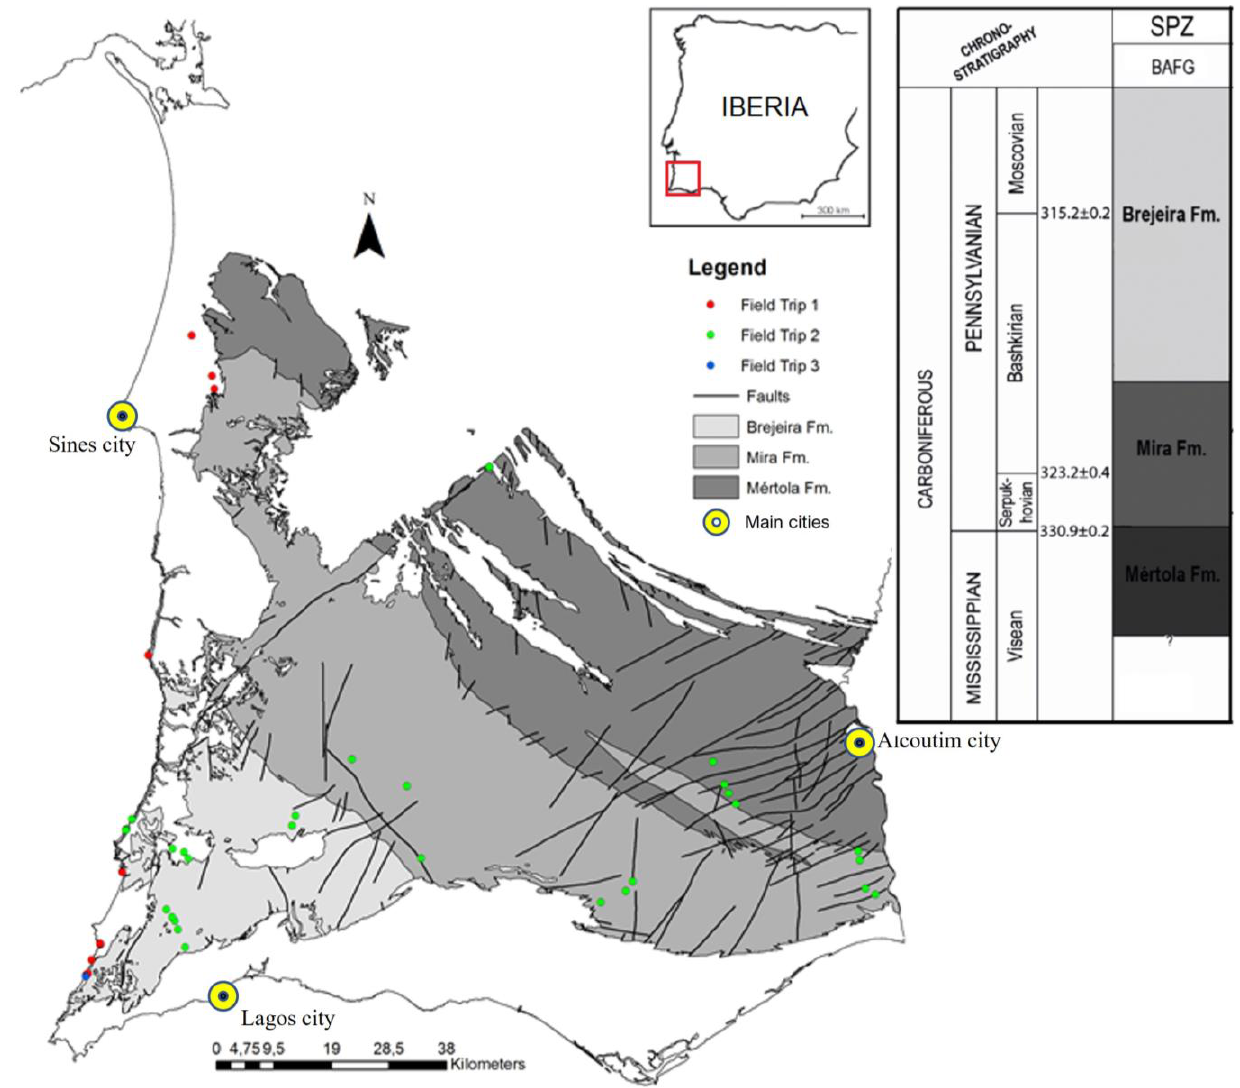
Figure 1. The SPZ geological map and stratigraphy, including location of the samples from field trips 1, 2, and 3. All samples from the 3rd field trip were collected in the same outcrop, thus being in the same location. The red square in the subfigure (Iberia map) represents the location of the SPZ.